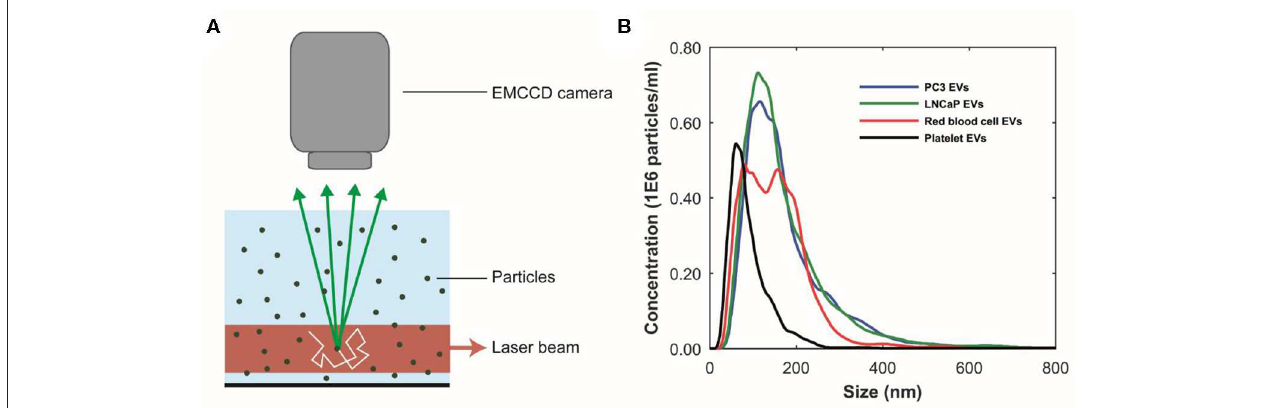
FIGURE 2 | Particle size distributions of extracellular vesicle (EV) samples measured using nanoparticle tracking analysis (NTA). (A) Schematic representation of the NTA setup. A laser beam illuminates the particles in suspension. The light scattered by particles undergoing random motion (white arrow) is collected by a microscope objective and detected by an multiplying charge-coupled device (EMCCD) camera. The random motion of the particles under Brownian motion can be related to their size. (B) NTA analysis results of the PC3EV (blue), LNCaP EV (green), red blood cell EV (red), and the platelet (black) EV samples, respectively. The bin width is 10nm. The mean particle size and concentration in the PC3EV sample are 172 ± 4nm and 1E8 particles/ml, respectively. The mean particle size and concentration in the LnCaP EV sample are 167 ± 4nm and 1E8 particles/ml, respectively. The mean particle size and concentration in the red blood cell EV sample are 148 ± 4nm and 1E8 particles/ml, respectively. The mean particle size and concentration in the platelet EV sample are 89 ± 5nm and 4E7 particles/ml, respectively. Because the uncertainty in the determined concentration with NTA is unknown, the determined concentration should be interpreted as an order of magnitude estimate ( 24). Images adapted from Lee et al. ( 25) and van der Pol et al.